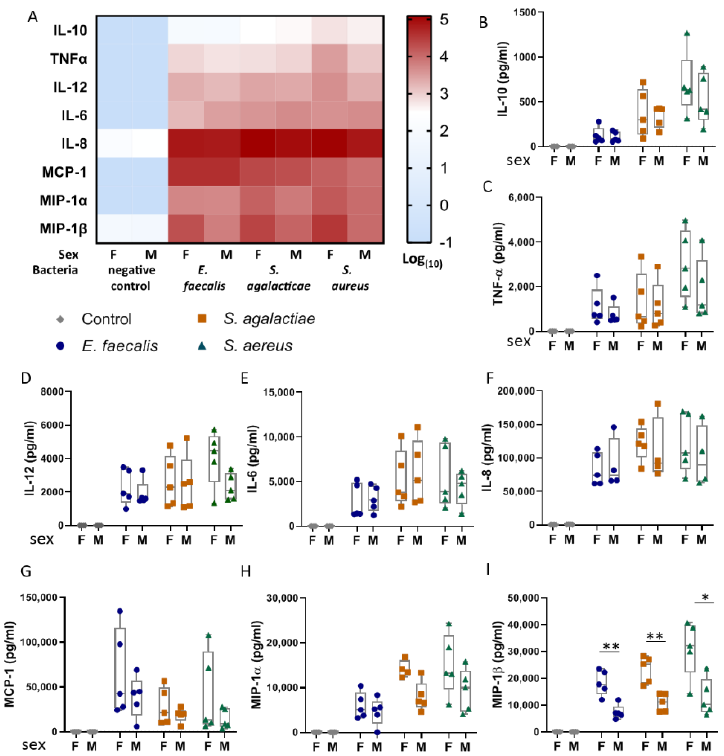
Figure 3. The sex of the infant determines the intensity of MIP-1β responses to bacterial lysates. ( A ) The heatmap presents in each row the median value for the cytokine and chemokines depicted in the left according to the treatment and the sex of the infants from whom the samples were collected (columns). The values are presented in logarithmic (10) scale as shown in the right. ( B – I ) The individual cytokines and chemokines detected upon stimulation with or without lysates from E. faecalis (circles), S. agalacticae (squares), S. aureus (triangles), and controls (diamonds) are presented in boxplots. For each bacteria lysate, the levels of the respective cytokines were compared between cultures of UBMC from female ( F ) and male ( M ) donors: * p < 0.05; ** p < 0.001. MannWhitney U Test. Boxplots represent the median, minimum, and maximal, whilst the dots depict the individual values. Of note, the sex of the sample donors had no influence on the levels of IL-8,